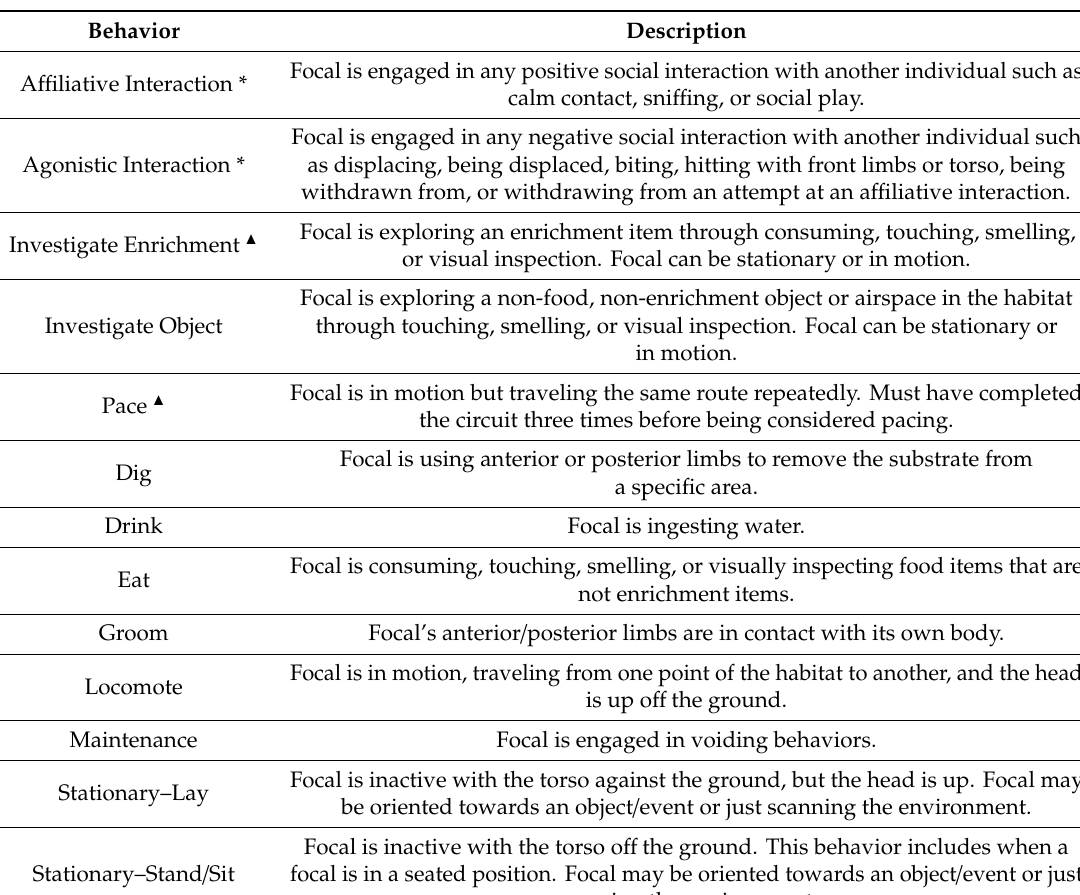
Table 3. Ethogram of behaviors. All behaviors were used for instantaneous scan sampling. Asterisks (*) are used to indicate behaviors that were also scored using all-occurrence sampling. For social all-occurrence behaviors, initiators and recipients were noted. Triangles ( (cid:78) ) are used to indicate behaviors that were scored using continuous sampling as